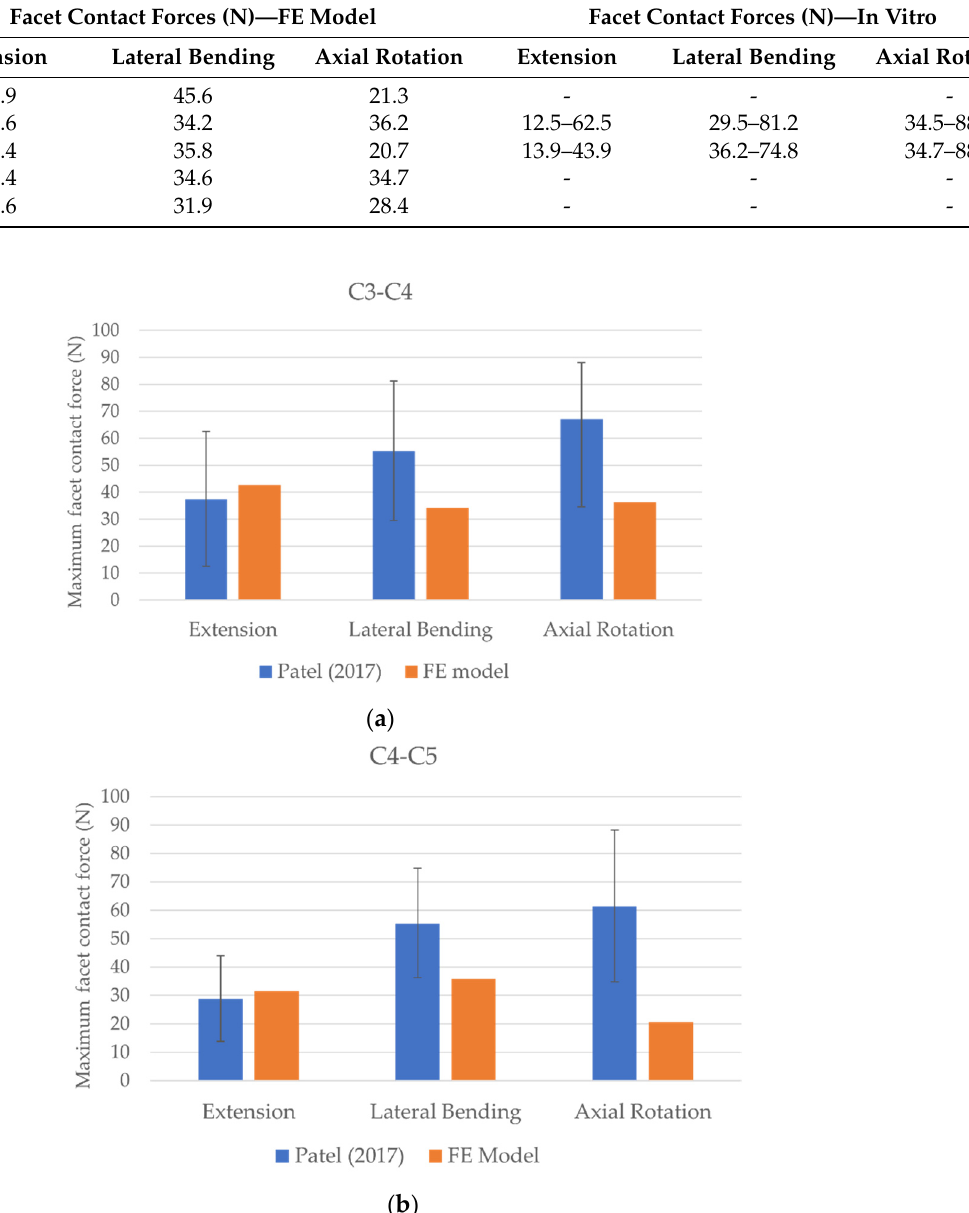
Figure 5. ( a ) Comparison of the facet contact forces at C3–C4 between the FE model results and the in vitro results reported in the literature [27] . ( b ) Comparison of the facet contact forces at C4–C5 between the FE model results and the in vitro results reported in the literature [27] .